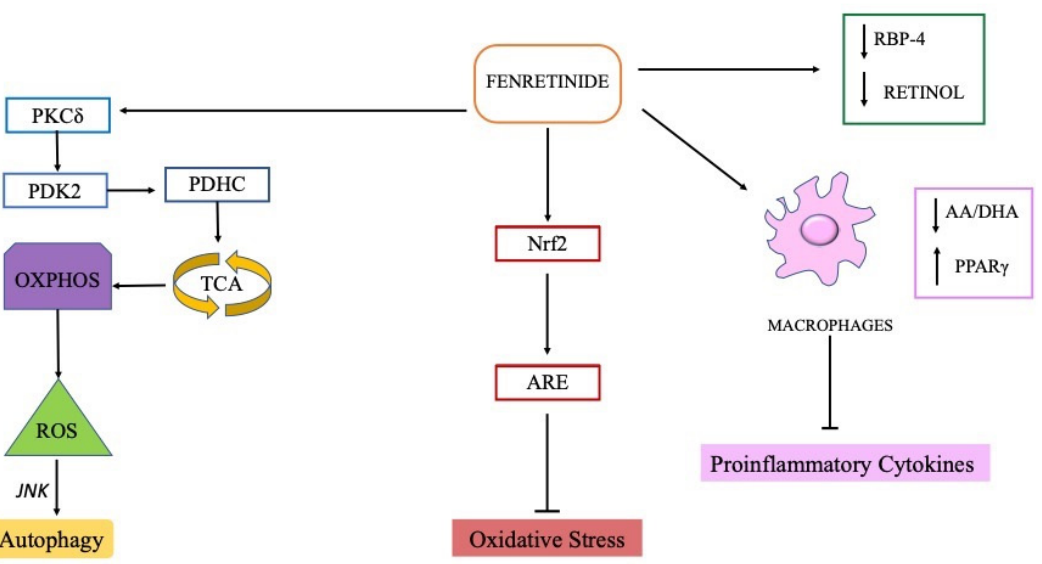
Figure 2. Schematic diagram of fenretinide activity in neurological diseases. Pointed arrows represent pathway activation, and blunt arrows represent pathway inhibition. Fenretinide activates PKC δ in the mitochondrial signalosome with consequent activation of PDK2, PDHC, TCA and increased ROS production. Low doses of fenretinide induce a moderate increase of intracellular ROS with activation of JNK autophagy pathway. Fenretinide decreases oxidative stress by improving the expression of the transcription factor Nrf2 that promotes the transcription of the antioxidant responsive element (ARE). Fenretinide downregulates the production of proinflammatory cytokines in macrophages by decreasing the AA/DHA ratio and enhancing the expression of PPAR γ . Fenretinide binds RBP4 in place of retinol thereby decreasing circulating levels of both retinol and